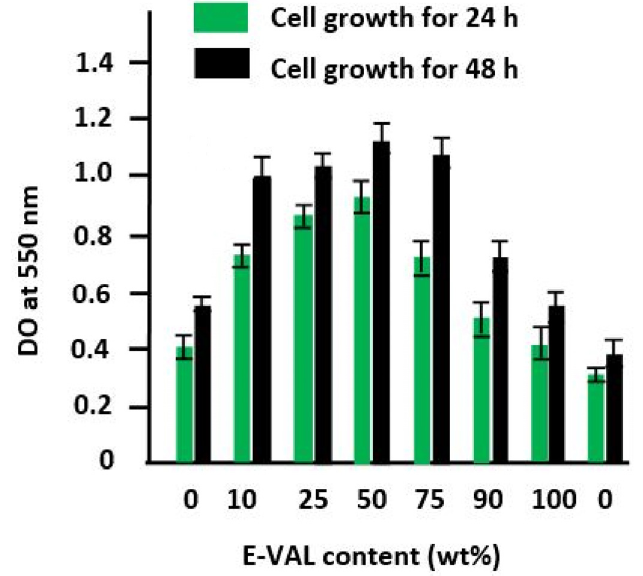
Figure 10. Cell growth tests on the pure PCL, pure E-VAL, and E-VAL / PCL materials with di ff erent E-VAL contents for 24 and 48